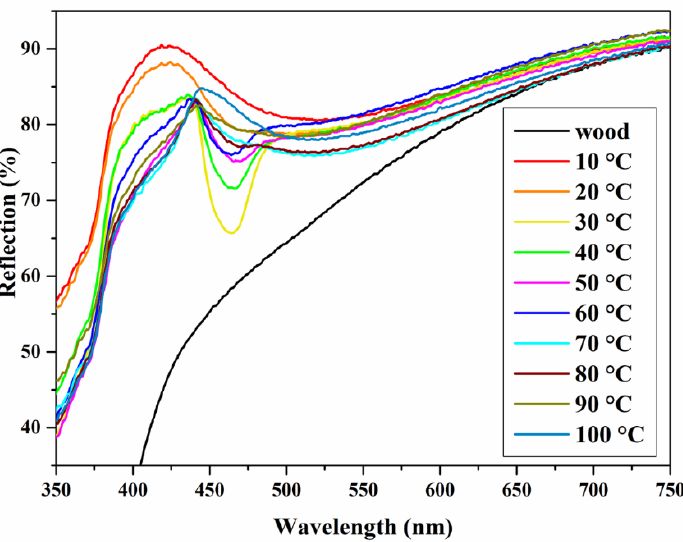
Figure 18. Reflection spectra of photonic crystals formed by self-assembly of P(St-AA) colloidal microspheres at different temperatures.